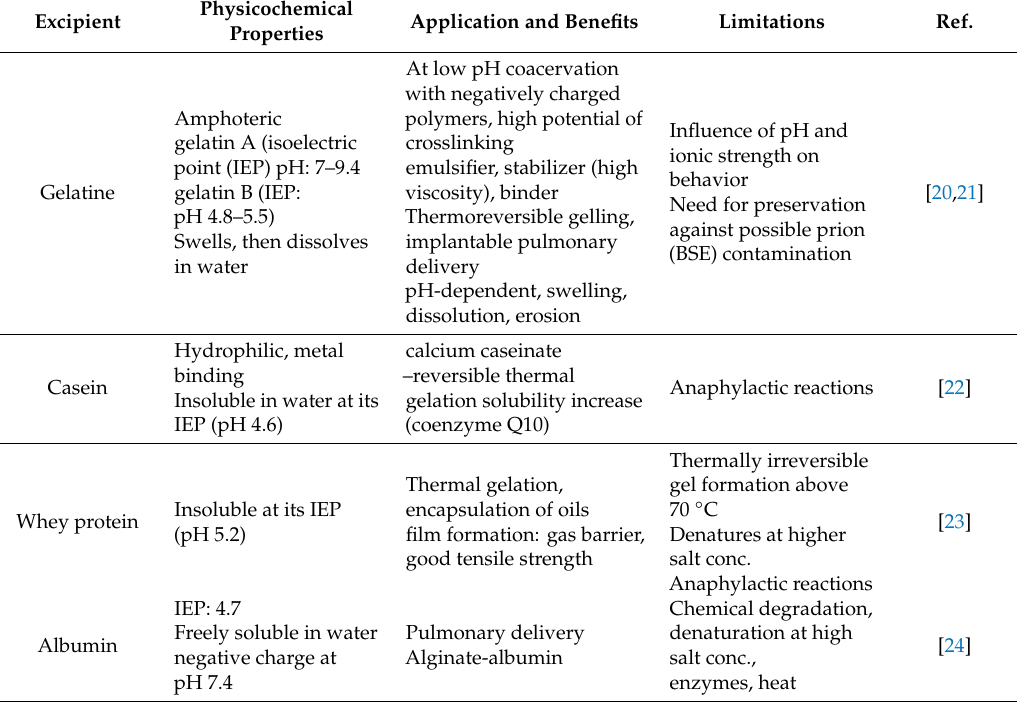
Table 1. Examples of proteins and waxes of plant or animal origin used in microencapsulation. Physicochemical Excipient Application and Benefits Properties